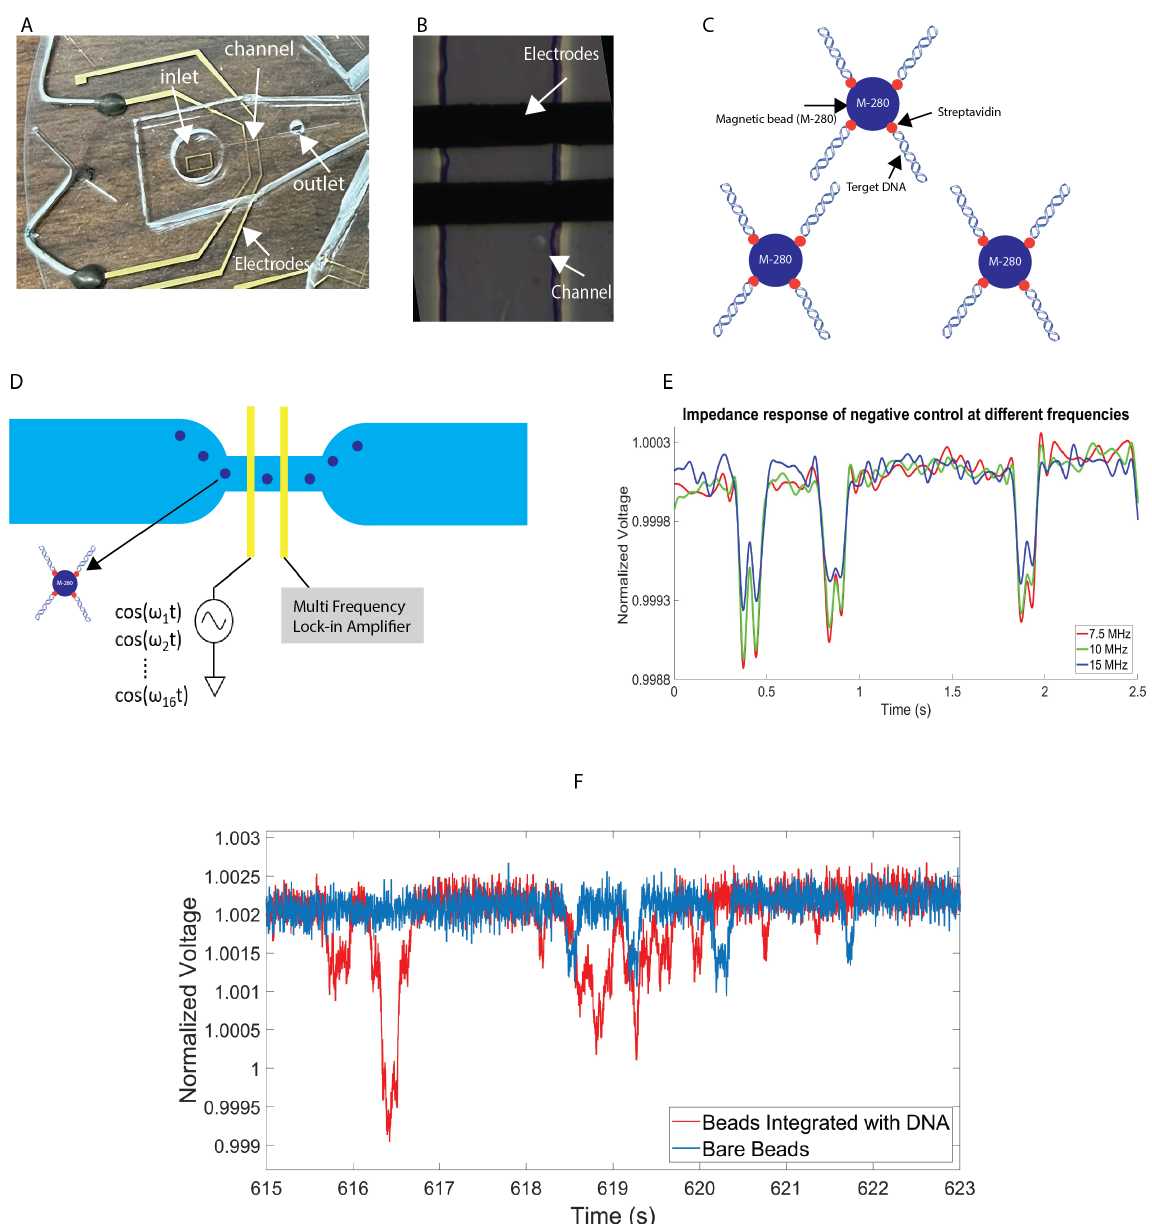
Figure 1. Overview of the process. ( A ) Image of device. ( B ) Microscopic image of channel and electrodes. ( C ) The sample preparation after binding of biotinylated DNA to paramagnetic beads. ( D ) The schematic diagram of detection. ( E ) Representative data of bare paramagnetic beads. ( F ) Representative data of bare paramagnetic beads and beads integrated with most-concentrated DNA.